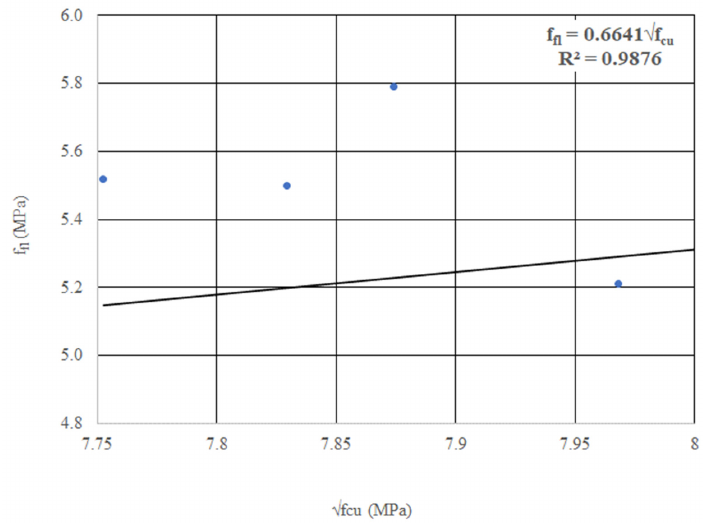
Figure 8. Correlation between compressive strength, f cu , and flexural strength, f fl .